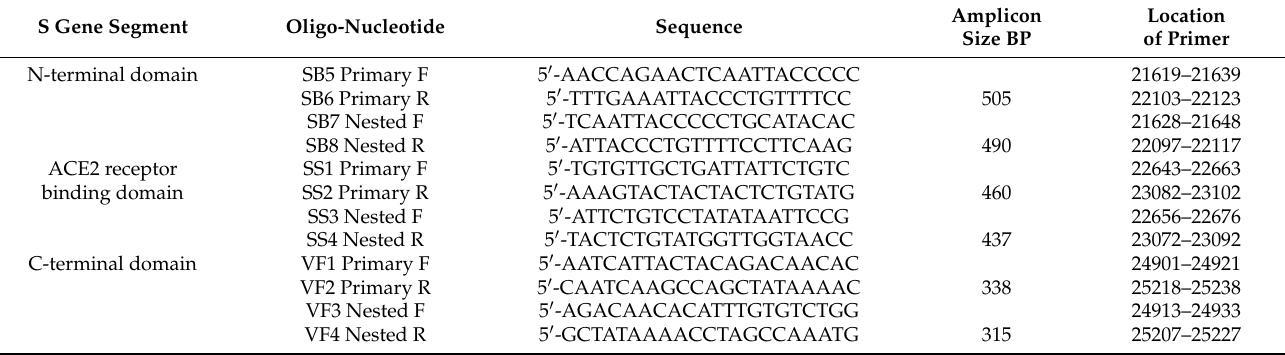
Table 2. Primary and nested PCR primers and their sequences used in this study.